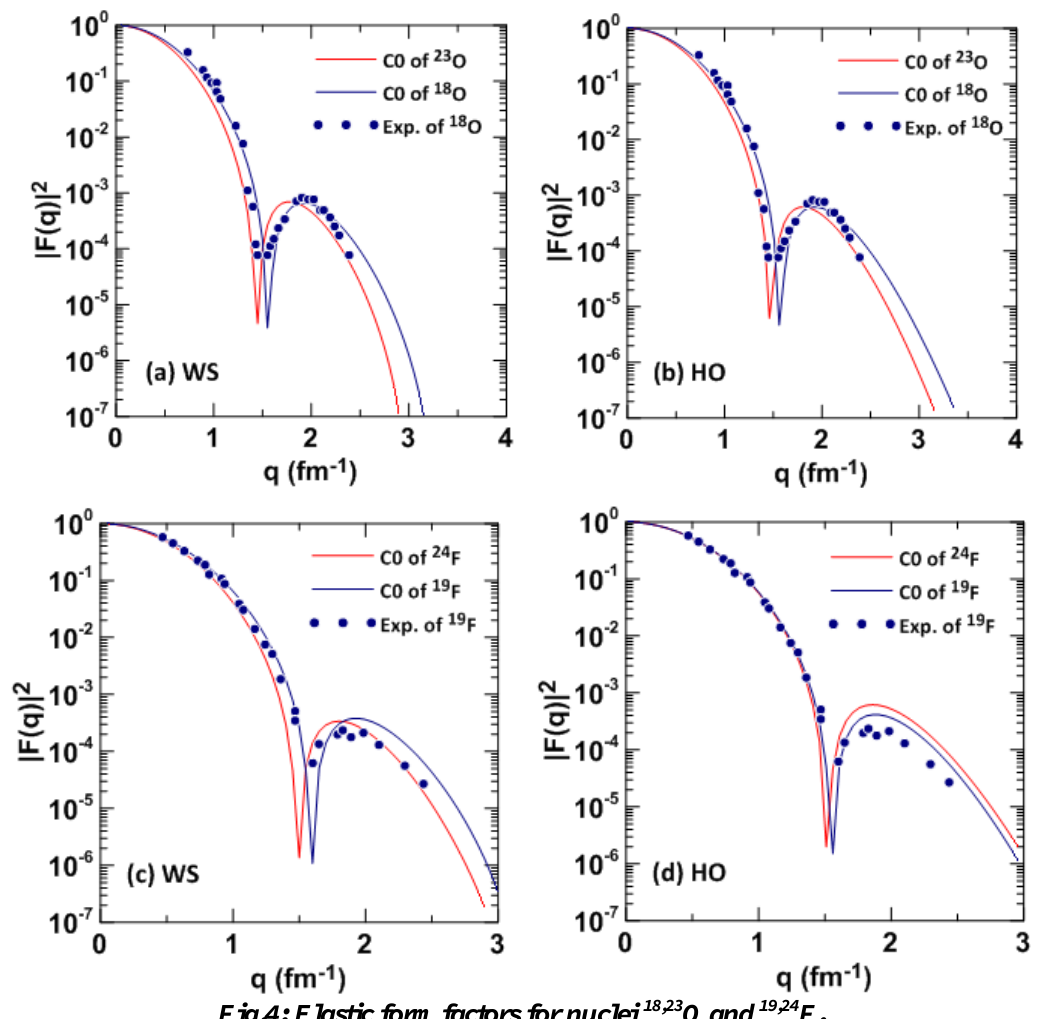
Fig.4: Elastic form factors for nuclei 18,23 O and 19,24 F.